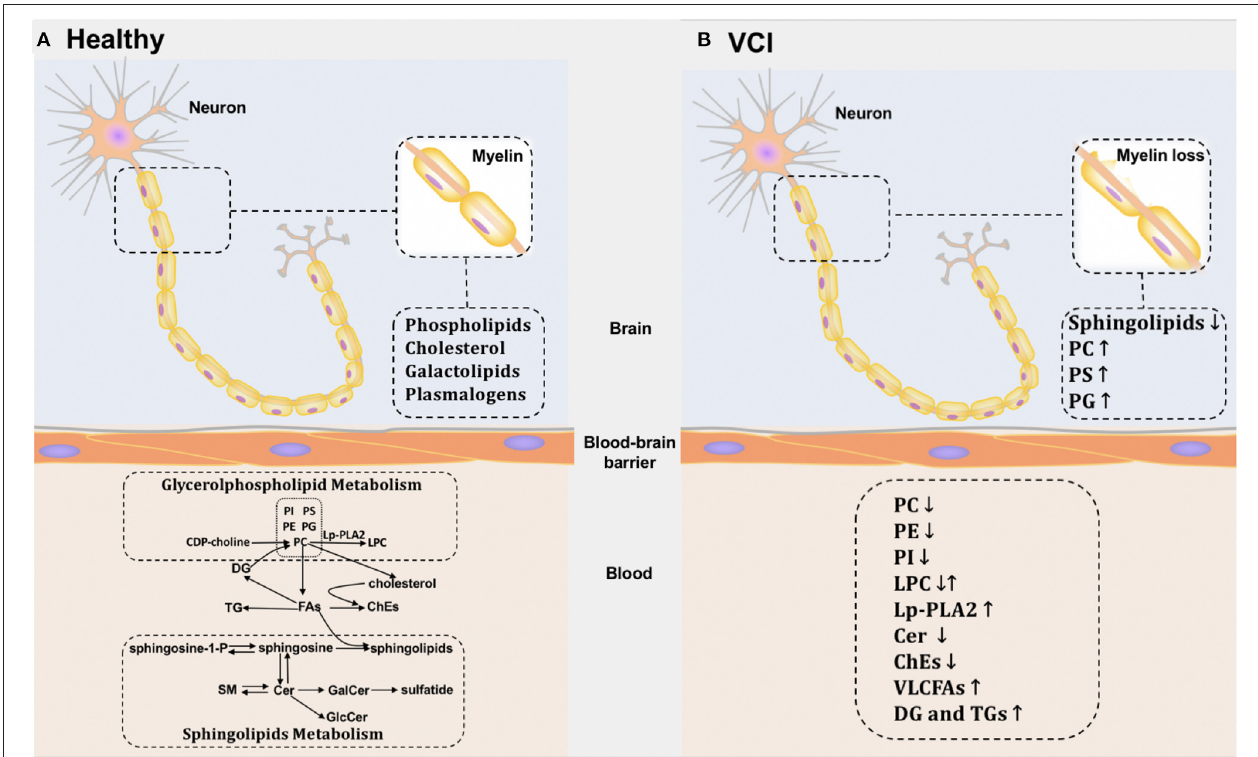
FIGURE 2 | Potential lipid metabolic pathways in brain and blood of healthy individuals and VCI patients. (A) The potential metabolic pathways of healthy individuals in brain and blood. (B) The potential metabolic pathways of VCI patients in brain and